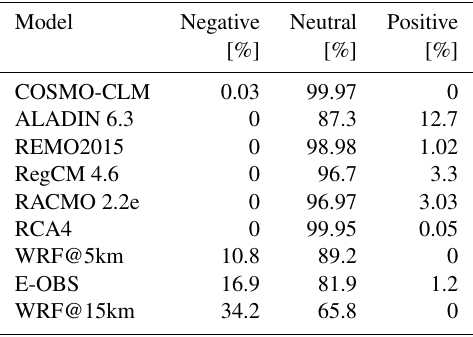
Table 6. SPEI-3 trends overall